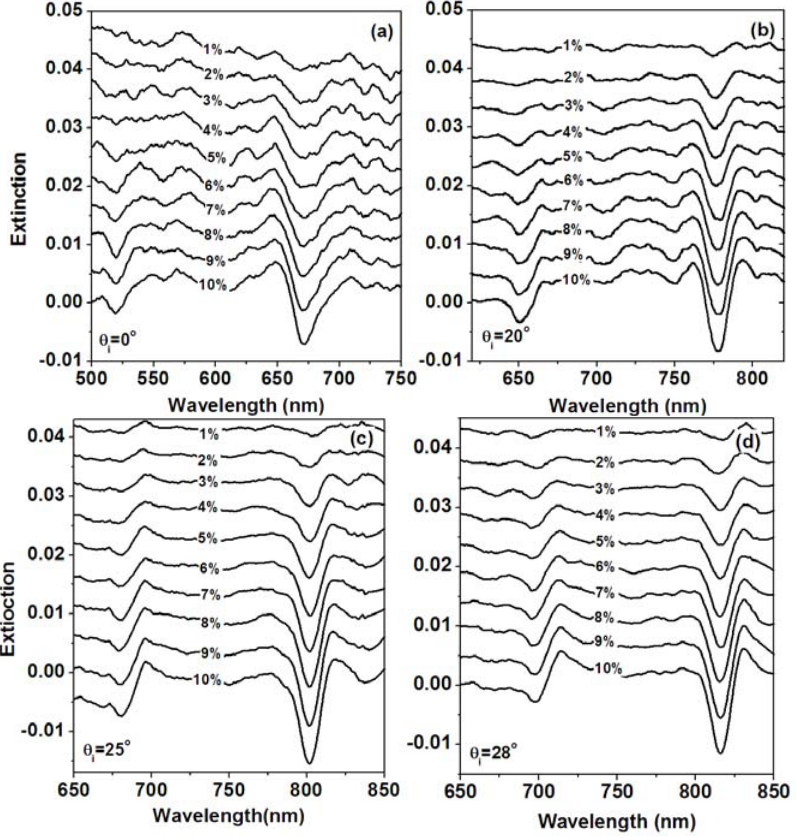
Figure 13. The measured sensor signals defined by the extinction spectra for glucose solutions with the concentrations changed from 1% to 10% with the transmission spectrum for pure water (a concentration of 0%) used as the blank for an incident angle of ( a ) 0; ( b ) 20 degrees; ( c ) 25 degrees; and ( d ) 28